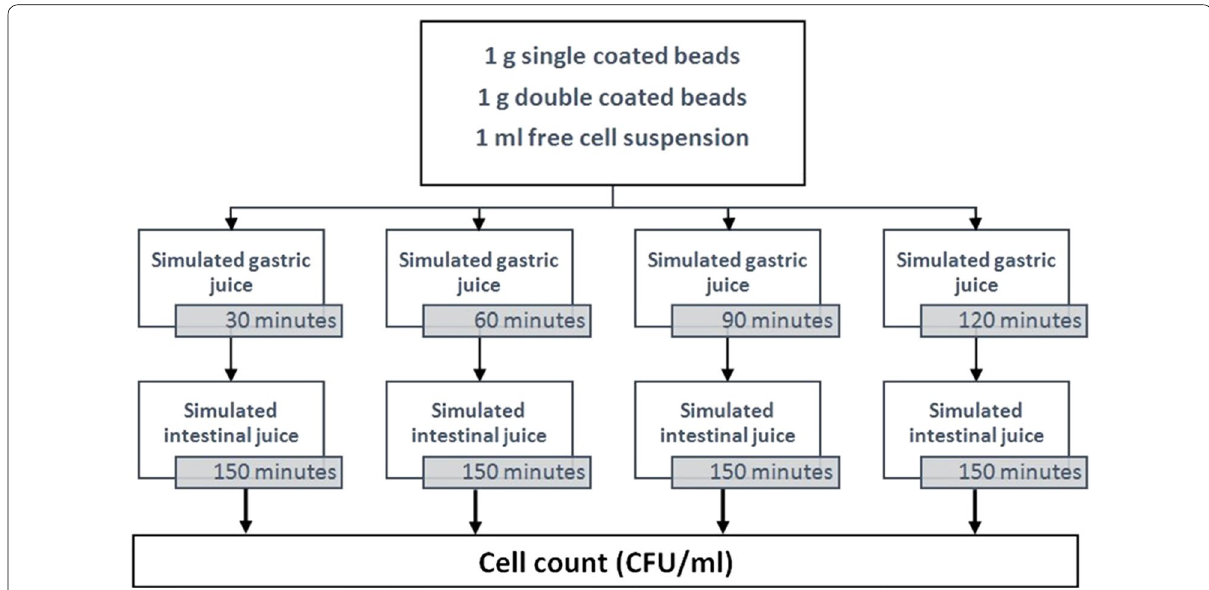
Fig. 2 The diagram of the experimental process of survival of microencapsulated probiotic bacteria following sequential incubation in simulated gastric and intestinal